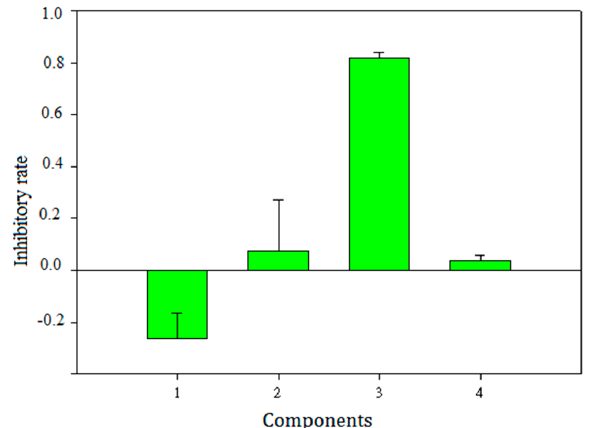
Figure 6. Inhibitory rates of different components 1 , 2 , 3 and 4 to RAW264.7 growth. Components 1 , 2 , 3 and 4 were obtained by separating the extract of Herba epimedii on a HPD resin column eluting with 10%, 50%, 80% and 100% ethanol, respectively.